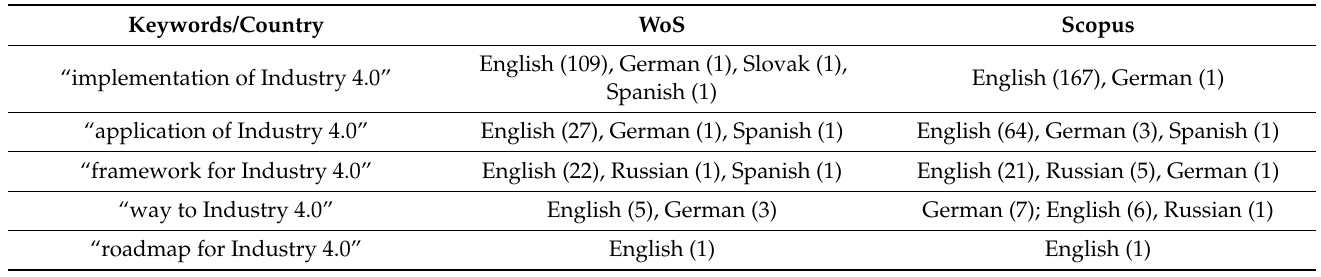
Table 9. Results of own literature review in the field: language of